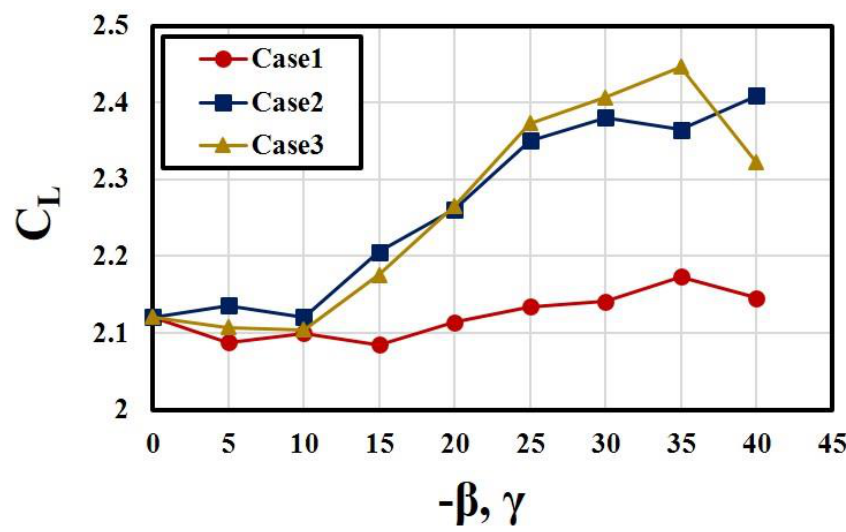
Figure 6. Variations of lift coefficient with pitch and/or bending angles of fluidic oscillators (α = 8°, δ f = 40°, C μ = 2.64%).